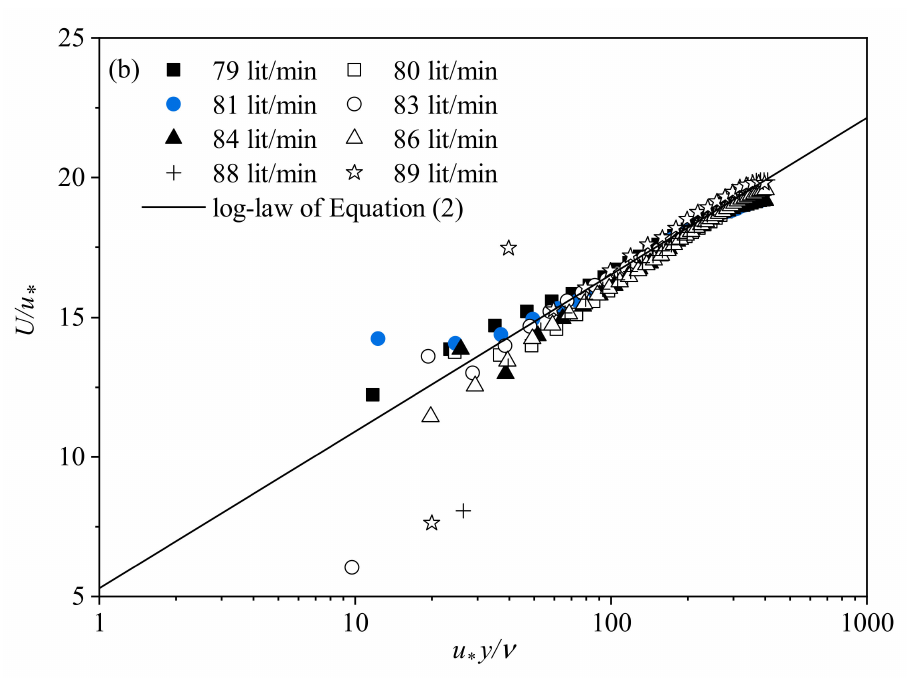
Figure 3. Vertical distributions of primary mean velocity with log-law: ( a ) sand zone; and ( b ) smooth zone.